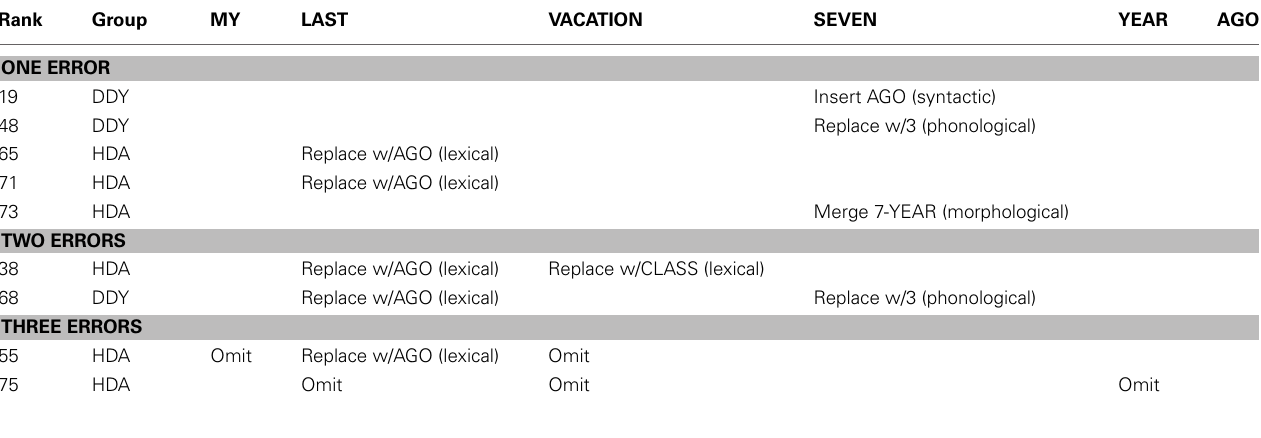
Table 4 | Frequency and type of error made for sentence item